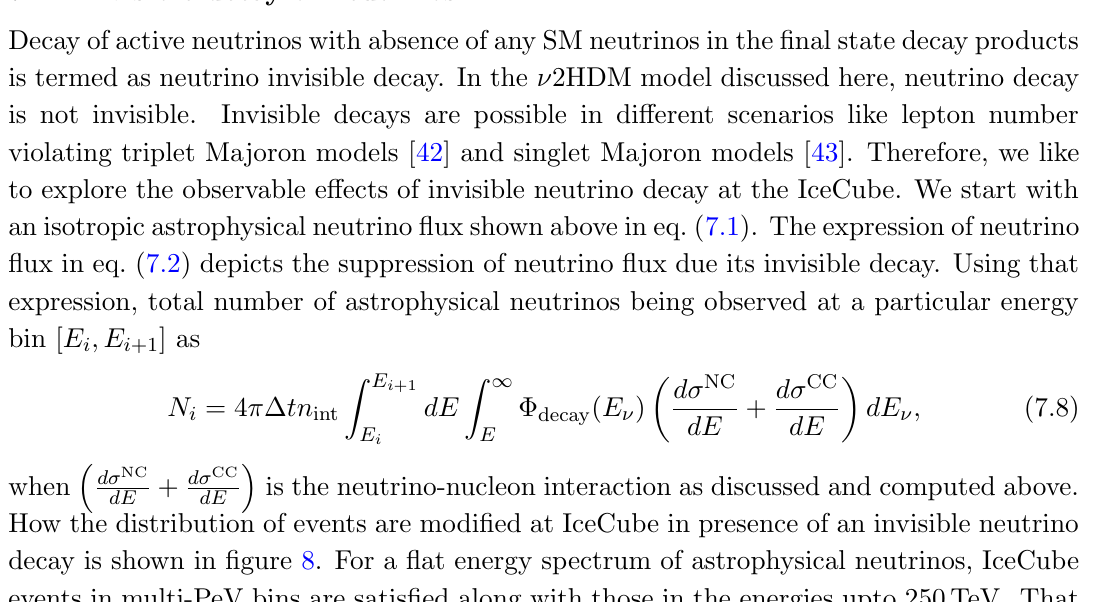
Figure 8 . IceCube event distribution for an invisible neutrino decay with a. moderate (cid:13)ux amplitude, relatively (cid:13)at spectrum and small decay e(cid:11)ects ((cid:8) 0 (cid:13) = 3, (cid:12) = 5 (cid:2) 10 4 GeV (left) b. high (cid:13)ux amplitude, steeper spectrum and large decay e(cid:11)ects ((cid:8) 0 = 2 (cid:2) 10 (cid:0) 17 (GeV cm 2 s sr) (cid:0) 1 , (cid:13) = 2 : 75, (cid:12) = 2 (cid:2) 10 5 GeV) (right). Atmospheric neutrino astro background is shown as brown shaded